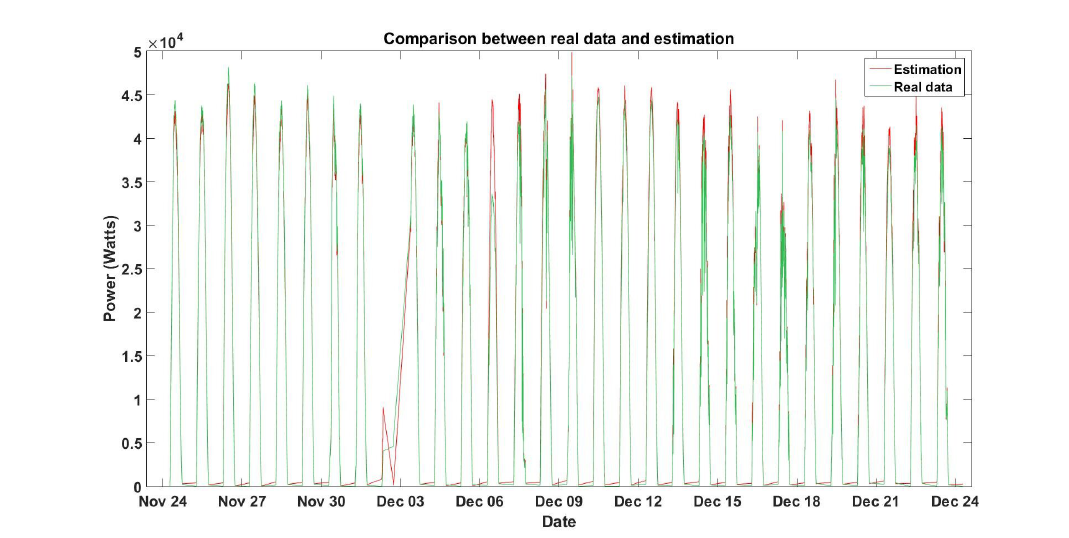
Figure 10. MLR results from MCS.